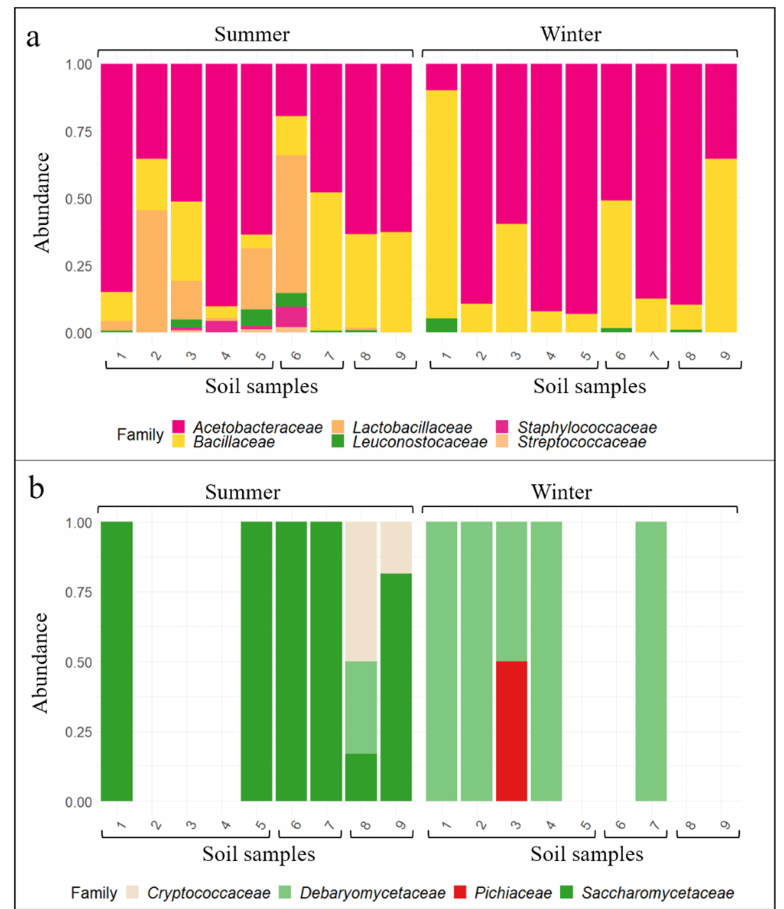
Figure 3. Abundance of wine-related bacterial ( a ) and fungal ( b ) families in soil samples and classified according to the soil characteristics (Sandy (1–5), clayey (6–7) and calcareous (8–9)) and the season (summer and